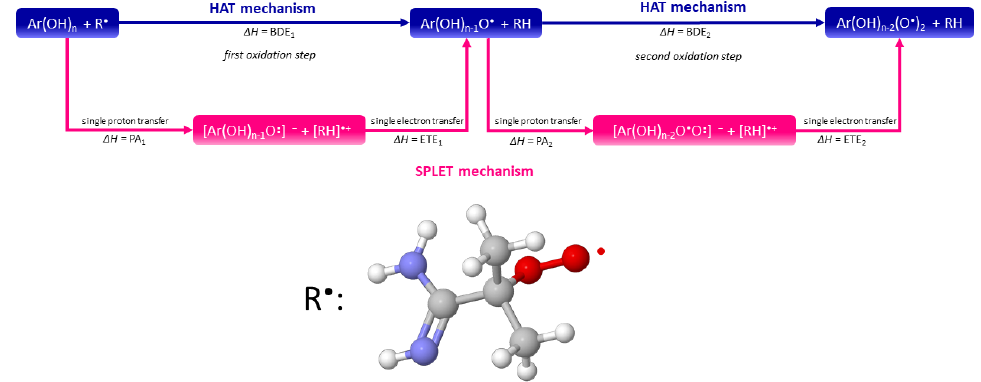
Figure 6. Schematic representation of the hydrogen atom transfer (HAT) and sequential proton-loss electron transfer (SPLET) mechanisms (adapted from Figure S1 in Ref. [35]).